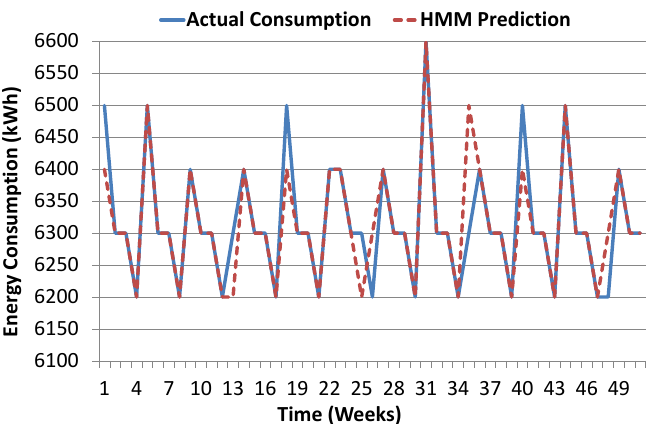
Figure 15. Proposed model prediction results in comparison with actual consumption for two months daily data.